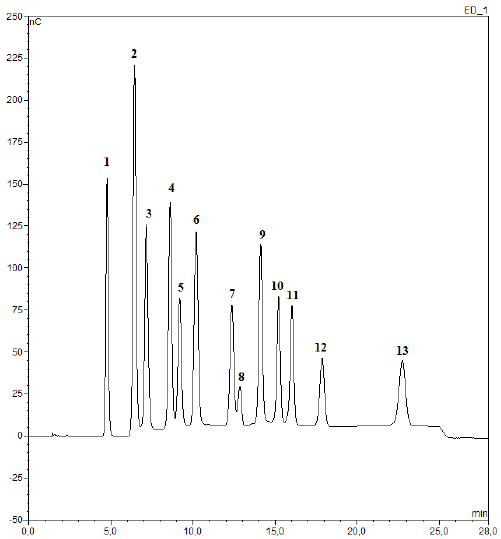
Figure 1. Chromatograms obtained by the high-performance anion-exchange chromatography with pulsed amperometric detection (HPAEC–PAD) analysis of a standard mix of thirteen sugars (1) threalose, (2) glucose, (3) fructose, (4) sucrose, (5) isomaltose, (6) koijbiose, (7) melezitose, (8) palatinose, (9) isomaltotriose, (10) nigerose, (11) maltose, (12) erlose and (13) panose.